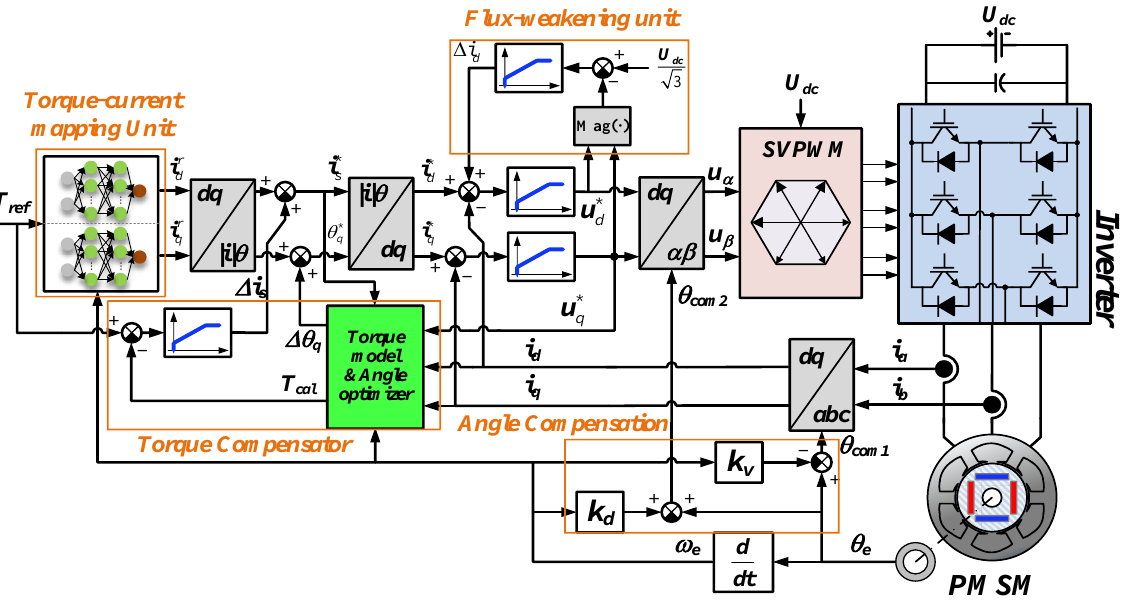
Figure 9. Static torque control block diagram with online torque compensation (the variables marked by * stand for expected values).